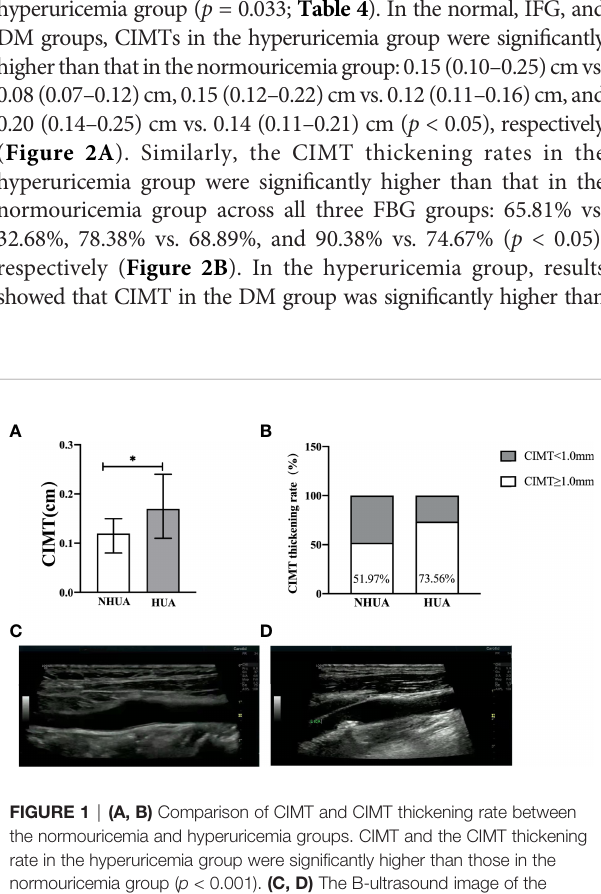
Figure 3F ]. Age was the most signi fi cant factor, and the inclusion of factors such as SBP, FBG, and SUA helped improve diagnostic ef fi ciency.